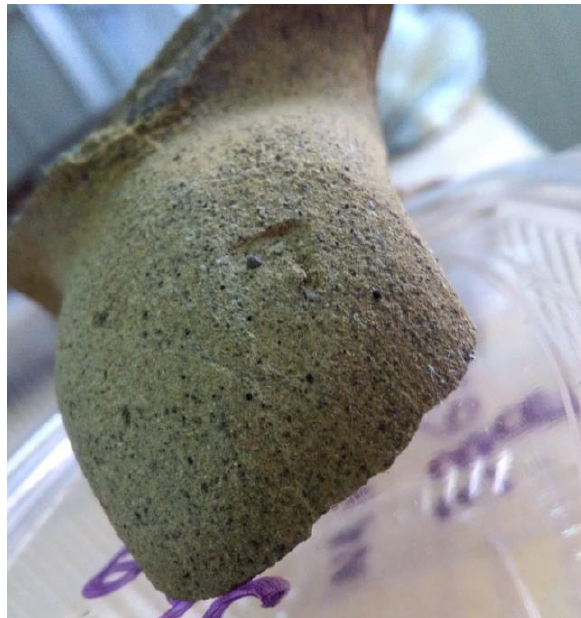
Figure 2 : Photo of stamp on production waste. Some stamps remain poorly legible even following 3D